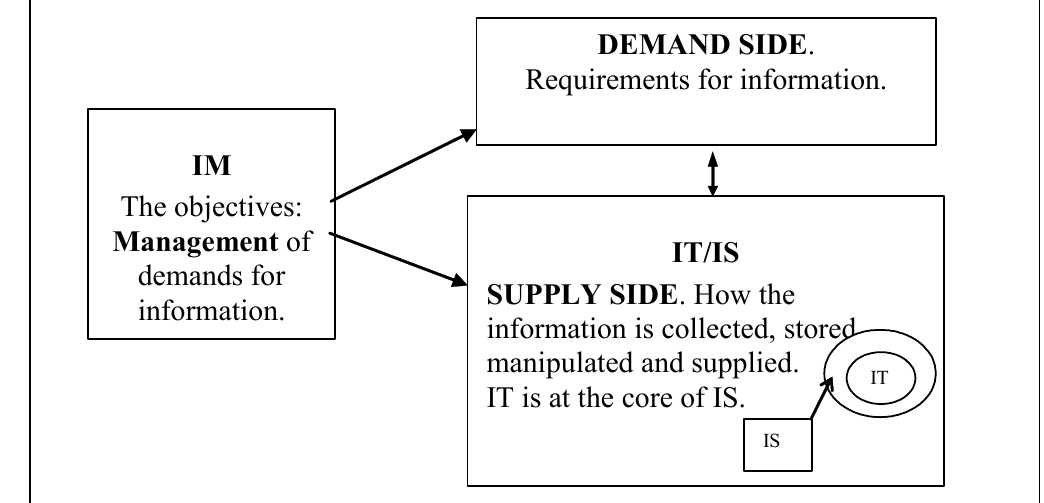
Figure 1: Objectives in information